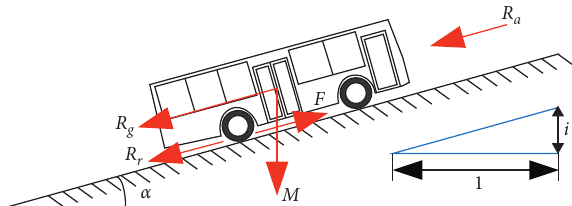
Figure 1: The static force condition of an EFV on a